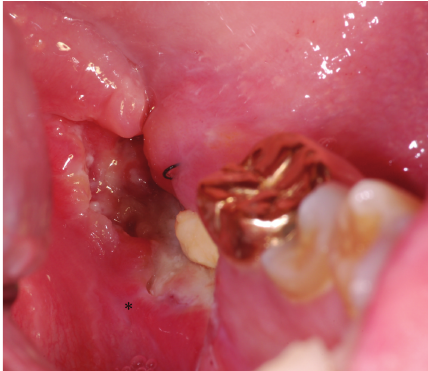
Figure 4: Case 2—the clinical aspect consists of a fibrin-coated ulcer in region of the wisdom tooth at the left lower mandible. The adjacent mucosa shows perifocal signs of inflammation ( ∗ ).